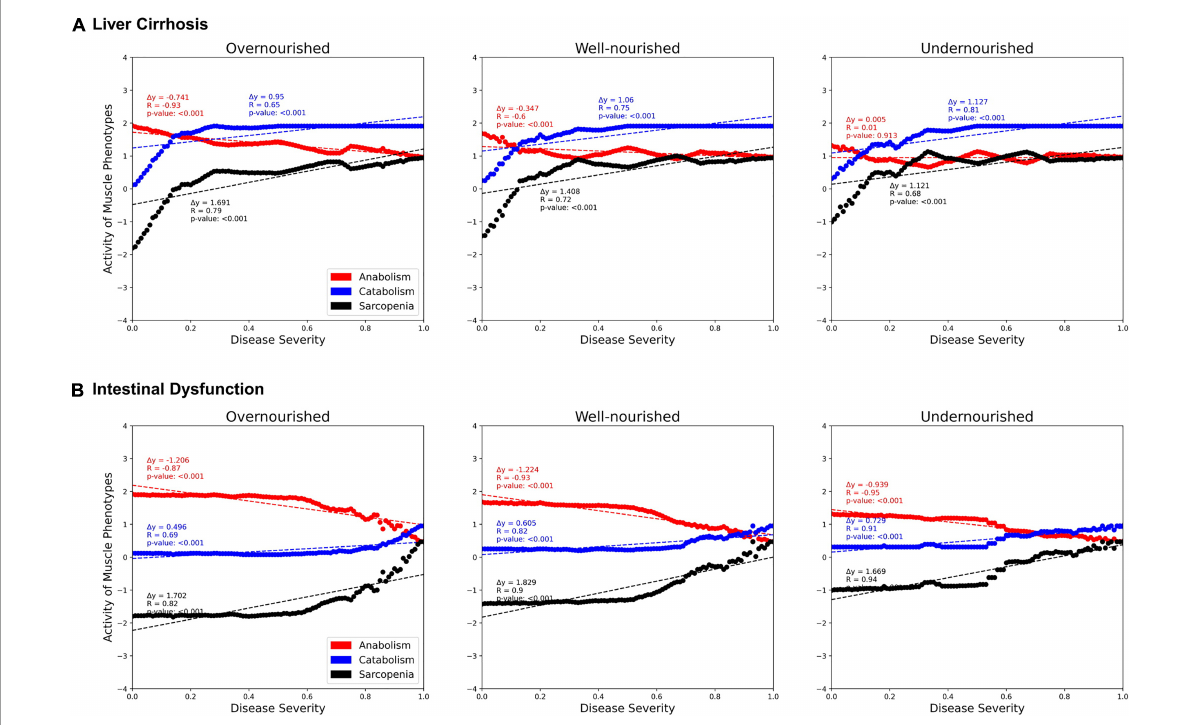
FIGURE6 Predicted activities of three muscle phenotypes in response to increasing severity of liver cirrhosis (LC, A ) and intestinal dysfunction (ID, B ) in three different nutrition states. Each point represents a simulation in which, starting from an initial state, signal transduction is iterated over 100 consecutive steps. During these steps, the state of LC or ID is set active with a defined frequency representing their